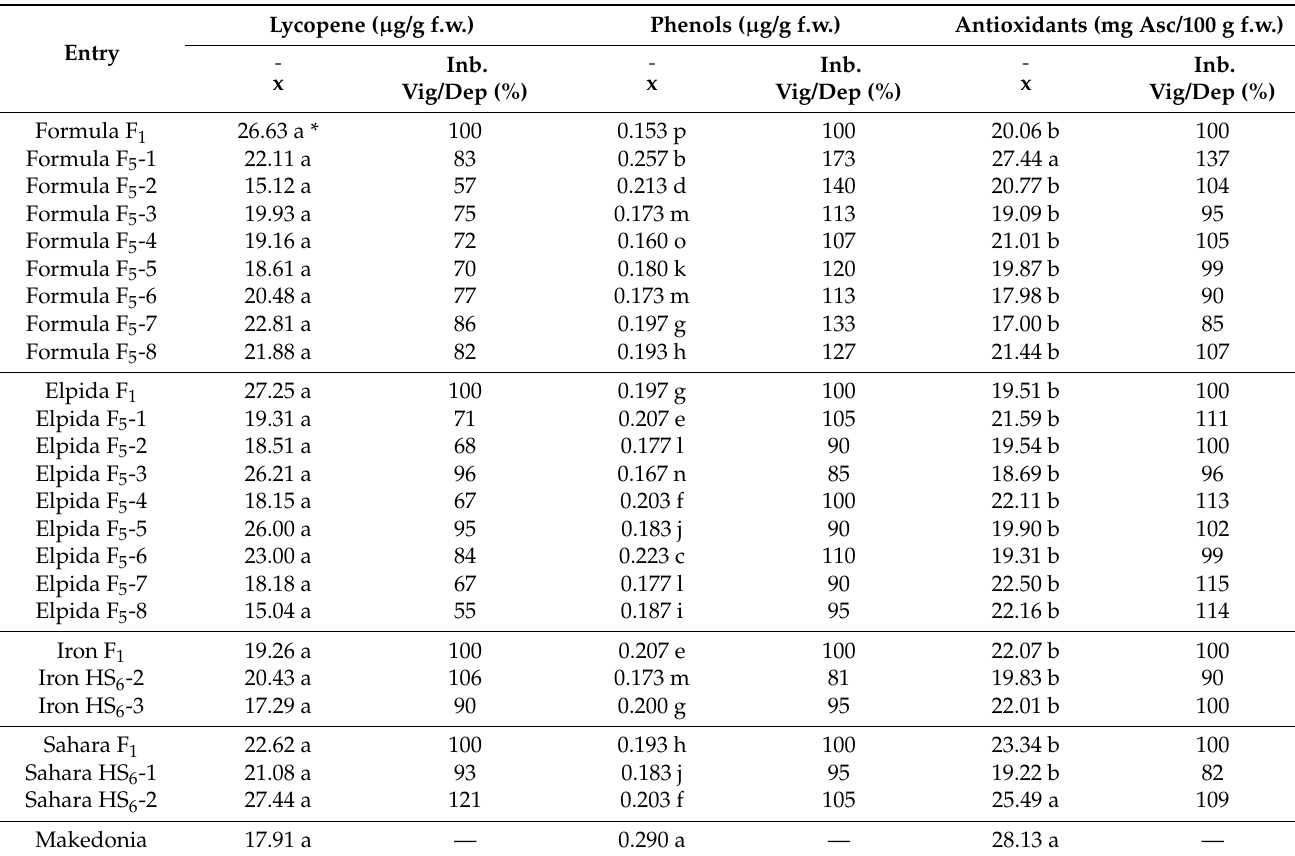
Table 3. Average fruit lycopene ( µ g/g f.w.), phenols ( µ g/g f.w.), antioxidants ( µ g Asc/100g f.w.) and inbred vigor/depression (% of corresponding hybrid), for tomato hybrids and recombinant inbred lines. Lycopene ( µ g/g